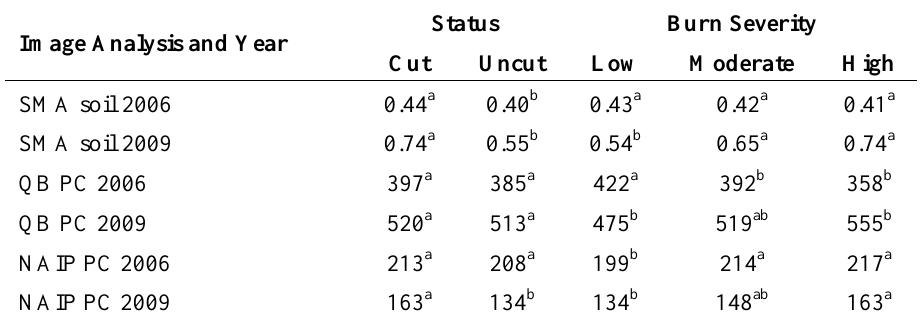
Table 5. School Fire SMA and PCA regression model results and tests of significance. The model form was: soil exposed or PC1 disturbance = cut | burn severity. Same letters (a,b) in a row indicate no significant difference at α = 0.05.